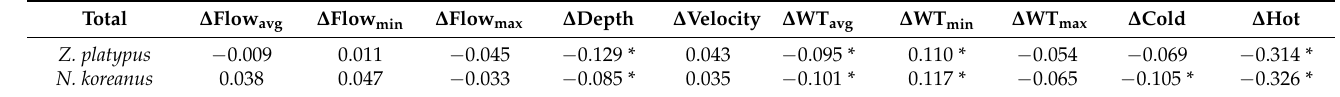
Table 2. Partial correlation coefficient ( ρ ) between changes in ecological habitat suitability (EHS) and environmental variables (Flow avg = annual average flow, Flow min = annual minimum flow, Flow max = annual maximum flow, Depth = annual depth, Velocity = annual velocity, WT avg = annual average water temperature, WT min = annual minimum water temperature, WT max = annual maximum water temperature, Cold = number of cold days, Hot = number of hot